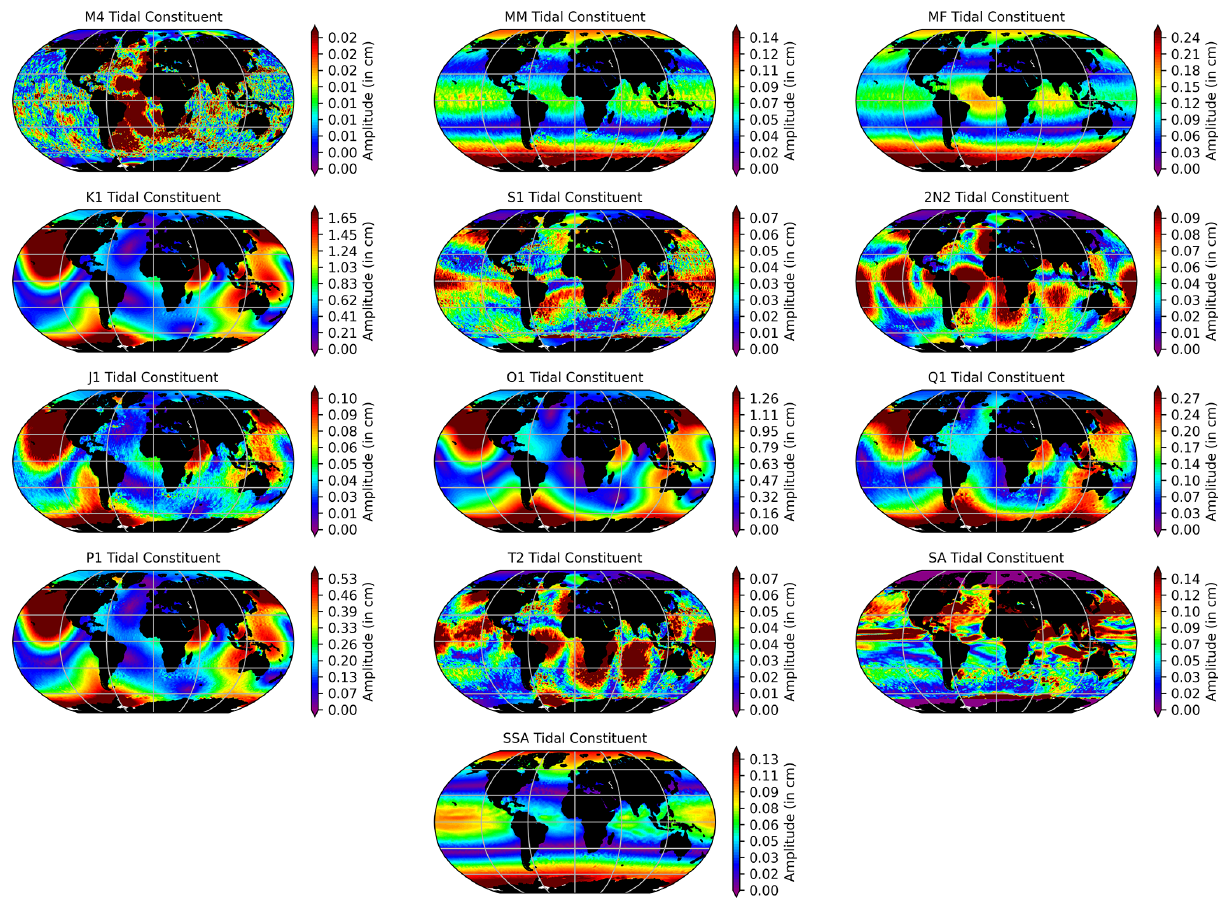
Figure A2. The amplitude of the remaining load tide constituents provided by EOT20. It should be noted that EOT20 does not make an estimation for the load tides on land.